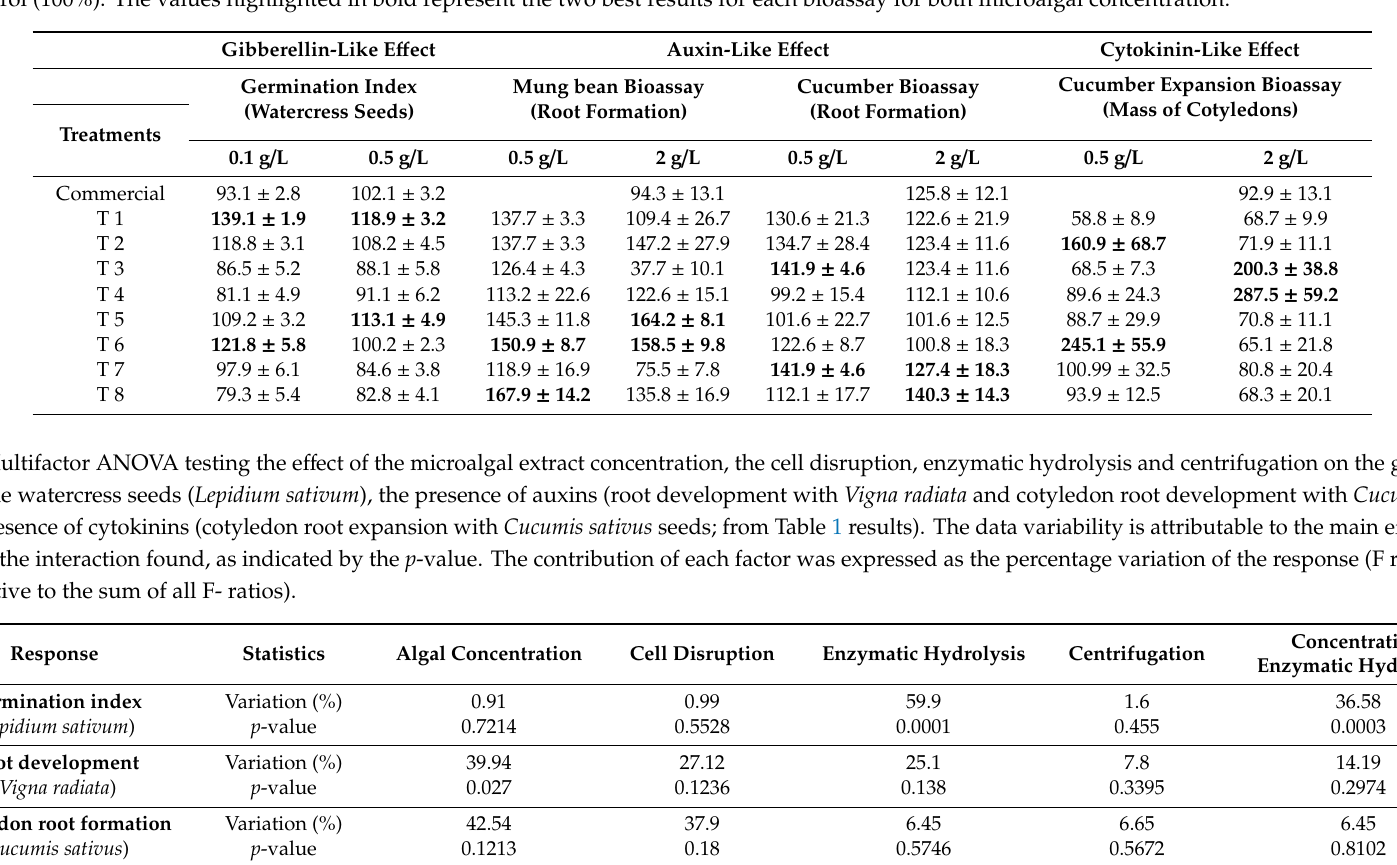
Table 1. Results of the four bioassays applied on the microalgal biomass from Scenedesmus obliquus for the eight treatments (T1–T8) tested at two di ff erent concentrations (in g / L). The gibberellin-like e ff ect was determined through a germination index bioassay in watercress seeds ( Lepidium sativum ), the auxin-like e ff ect was determined according to the mung bean ( Vigna radiata ) and cucumber ( Cucumis sativus ) cotyledon root formation bioassay and the cytokinin-like e ff ect according to the excised cucumber ( Cucumis sativus ) cotyledon root expansion bioassay. Results are expressed in a percentage as means ± standard deviation ( n = 3) considering distilled water as the control (100%). The values highlighted in bold represent the two best results for each bioassay for both microalgal concentration.